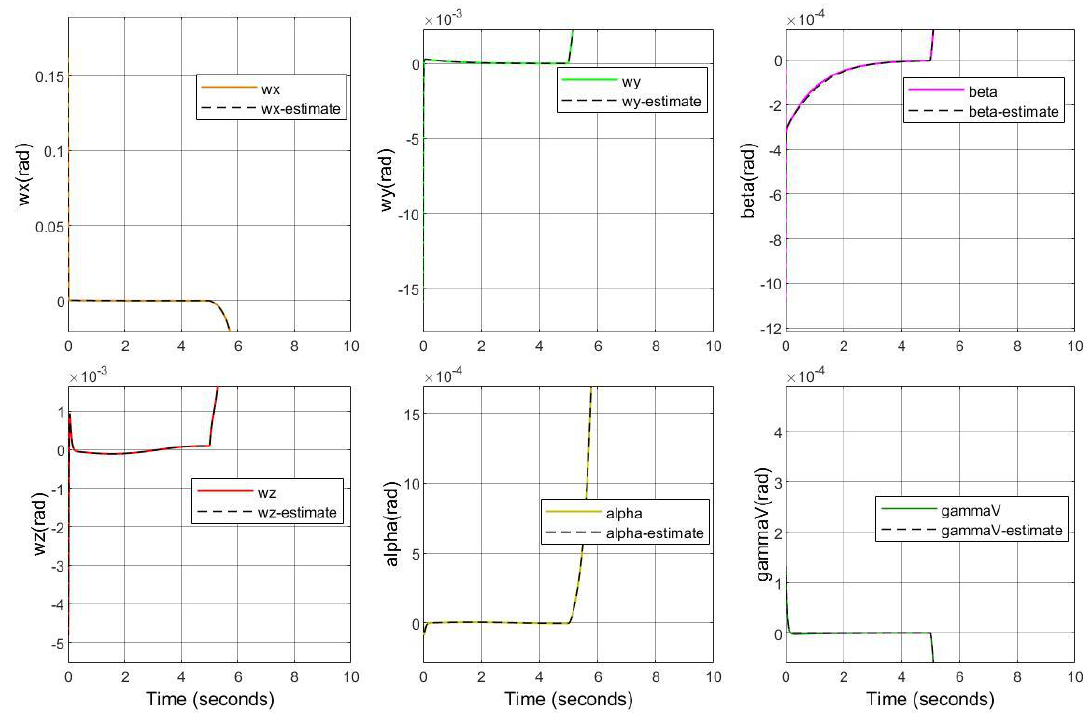
Figure 6. Detection simulation results of actuator stuck fault from input 3.